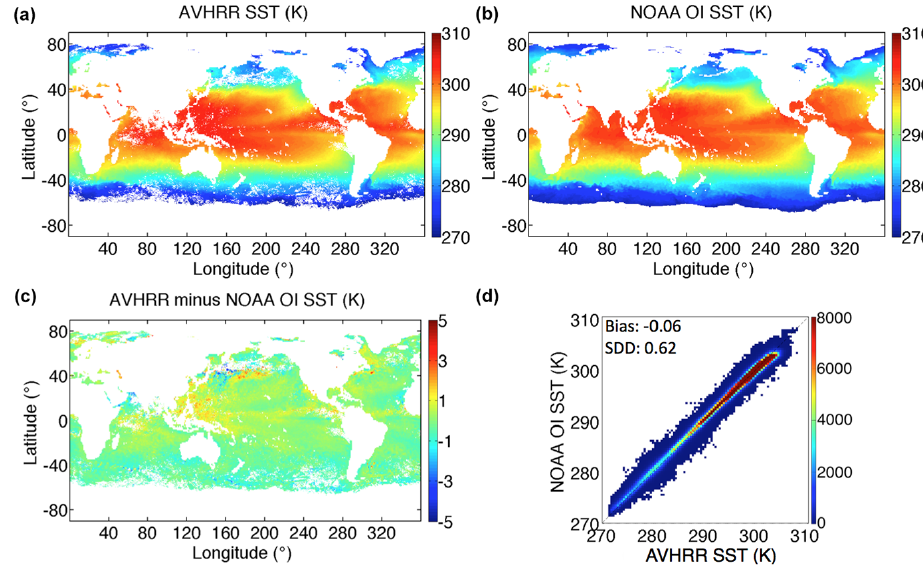
Figure 3. July 2008 (a) AVHRR SST, (b) NOAA OI SST, (c) SST difference, and (d) scatter density analysis of ∼ 3 million daily matched grid cells.